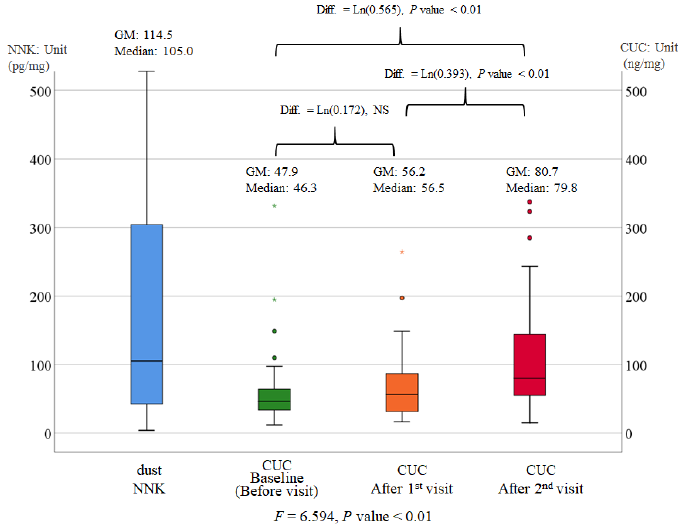
Figure 1. Dust NNK concentration and CUC concentration after the first and second visits. Re- peated – measures analyses of variance and post- hoc Fisher’s least significance distance tests were performed. The analysis was performed after values were log-transformed. CUC: creatinine-cor- rected urine cotinine, GM: geometric mean, NNK: nicotine-derived nitrosamine ketone, and NS: